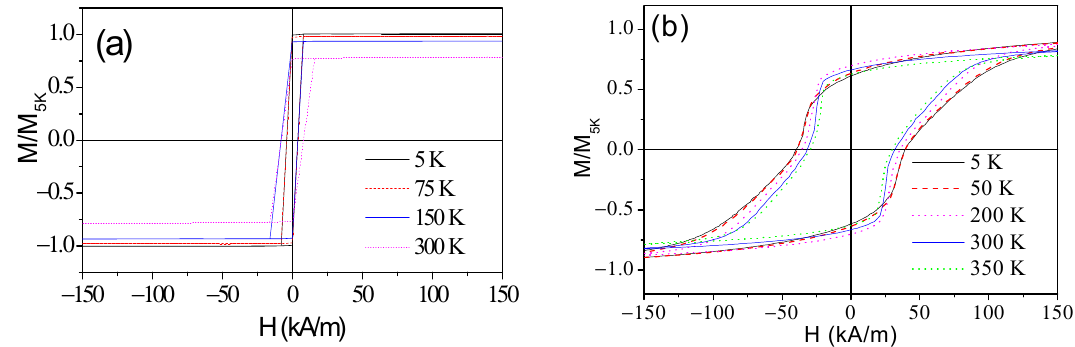
Figure 27. Hysteresis loops of as-prepared ( a ) and annealed at 500 °C for 1 h; ( b ) Fe 50 Pt 40 Si 10 microwires measured at different temperatures. Adapted from Ref. [114].